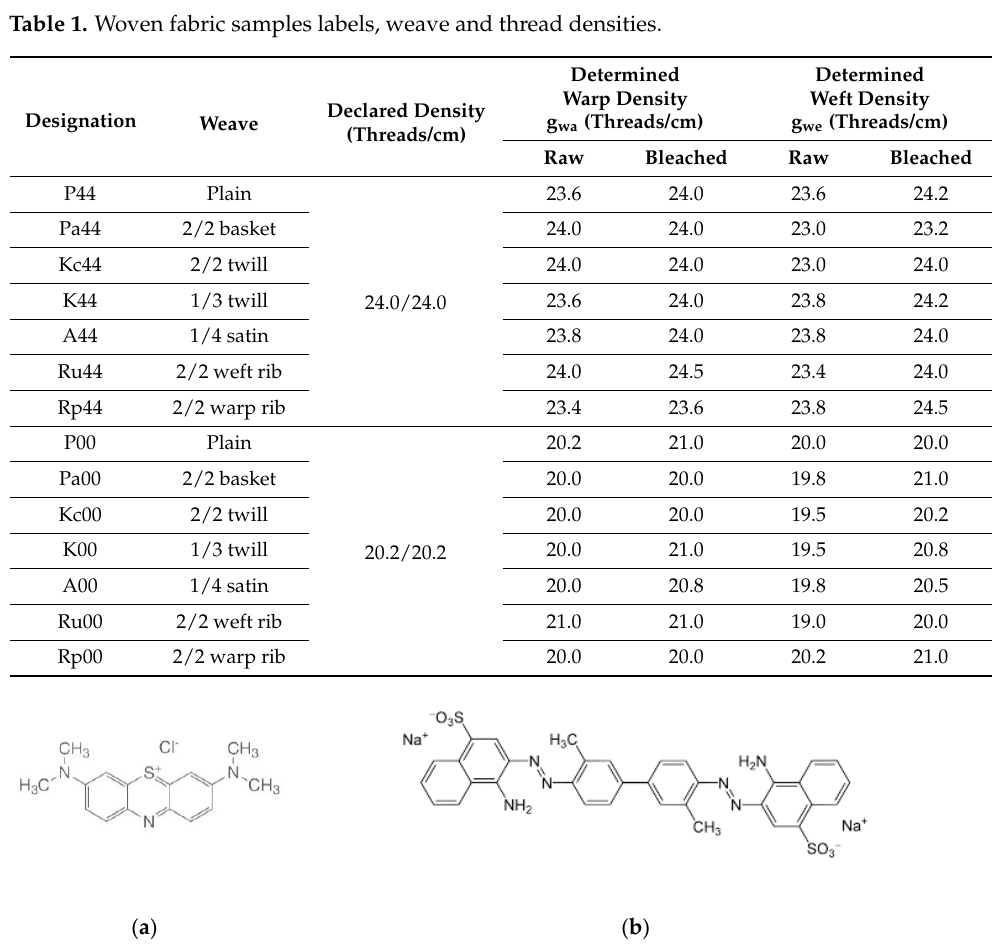
Figure 4. Chemical structure of ( a ) Methylene blue and ( b ) Benzopurpurine 4B. The dyes selected as contaminants are referred to as red dye and blue dye in the Results and Discussion sections. Table 1. Woven fabric samples labels, weave and thread densities.